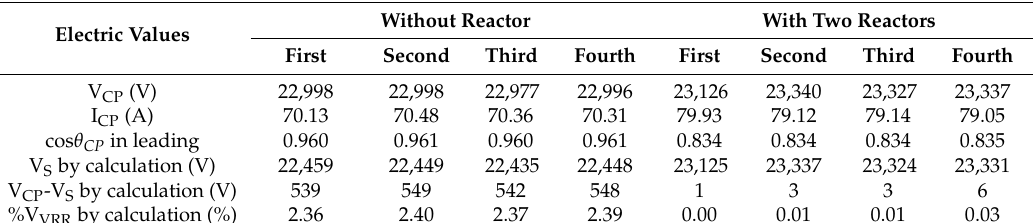
Table 4. Effectiveness of reactors.